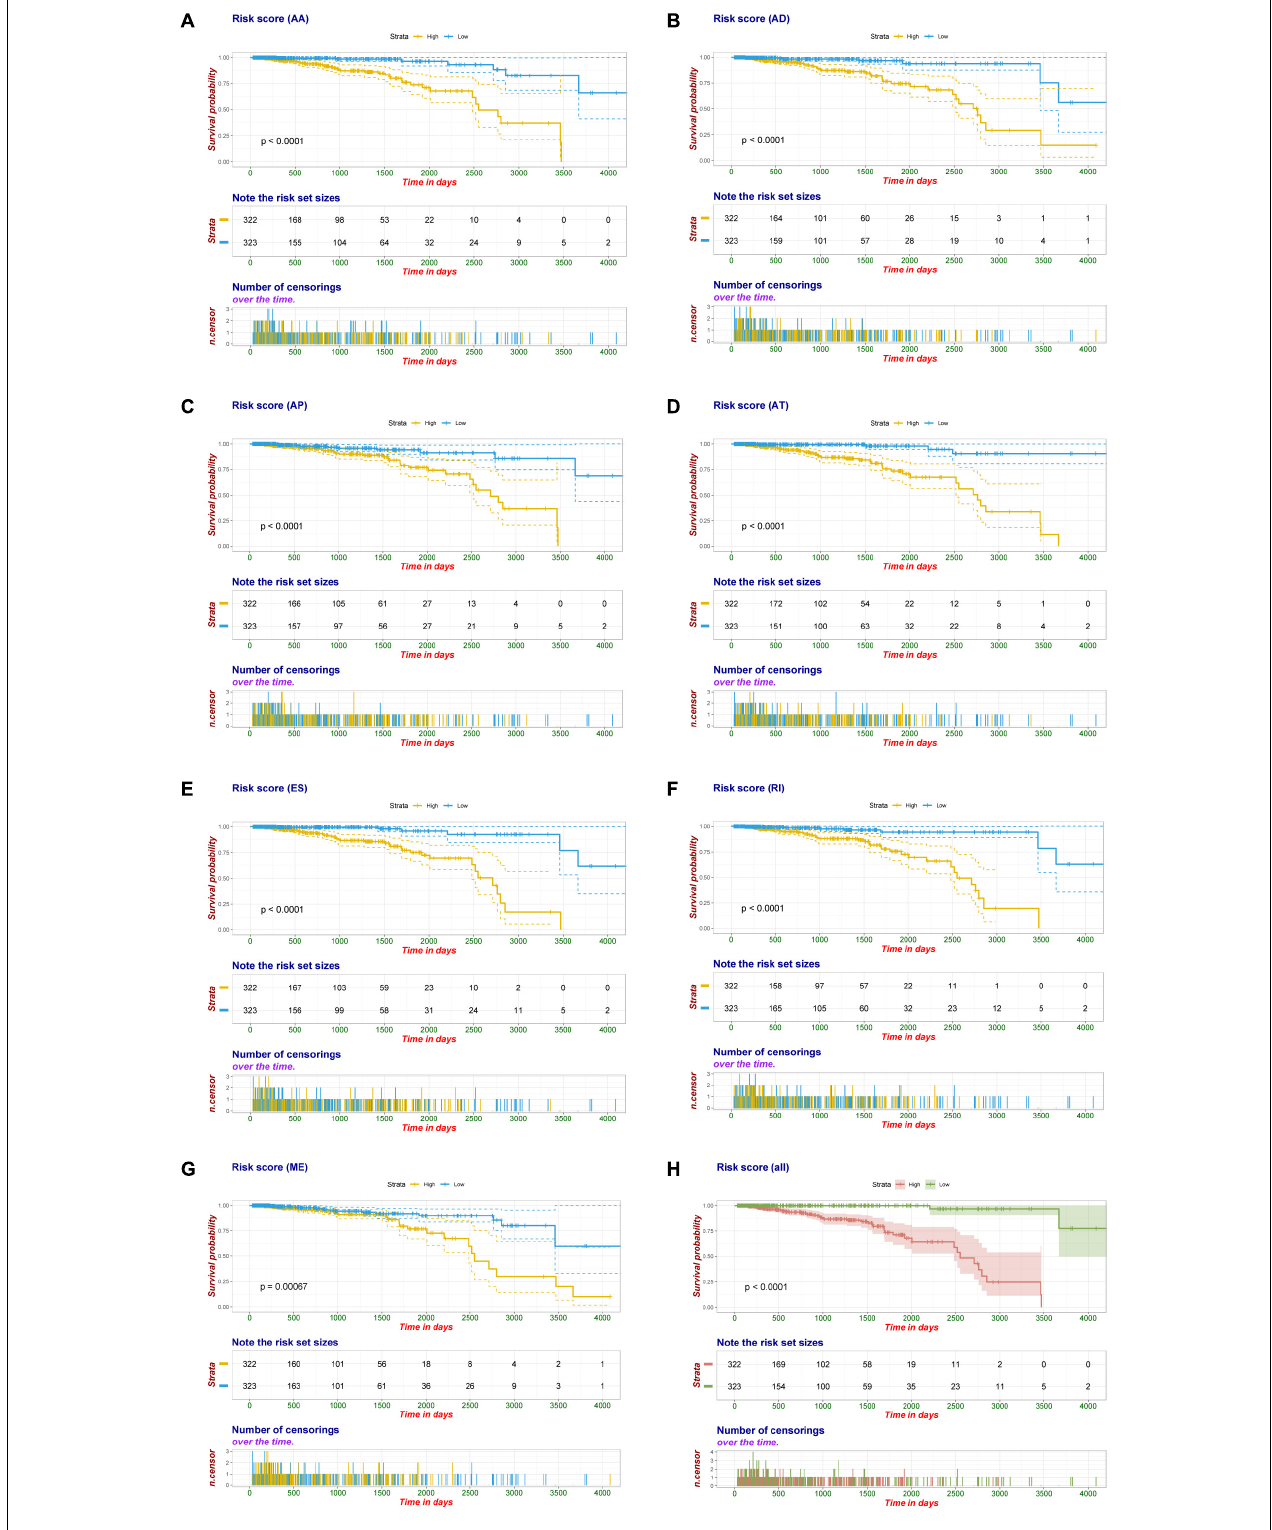
FIGURE 5 | Kaplan-Meier plot of prognostic signature built with AS events for BRCA patients. (A–G) Kaplan-Meier plot of prognostic signature built with AA, AD, AP, AT, ES, RI, and ME events, respectively. Yellow line indicates high-risk subgroup while blue line indicates low-risk subgroup. (H) Kaplan–Meier curves of final prognostic signature built upon all types of AS events for BRCA patients, in which red line represents high-risk subgroup and green line represents low-risk subgroup.